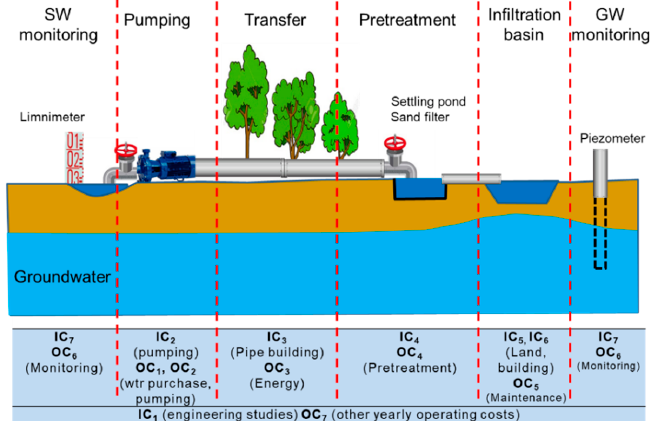
Figure 1. Main engineering components of a managed aquifer recharge (MAR) scheme with infiltration basin and associated investment (IC) and operating costs (OC).